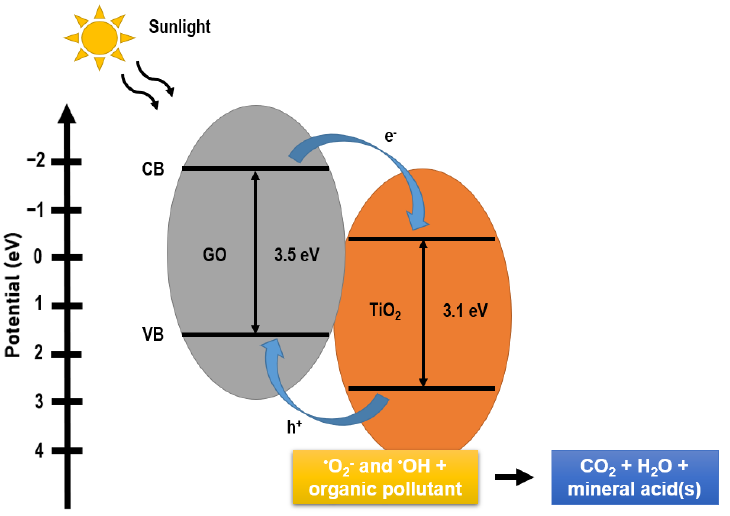
Figure 8. Mechanism of GO/TiO 2 composite.